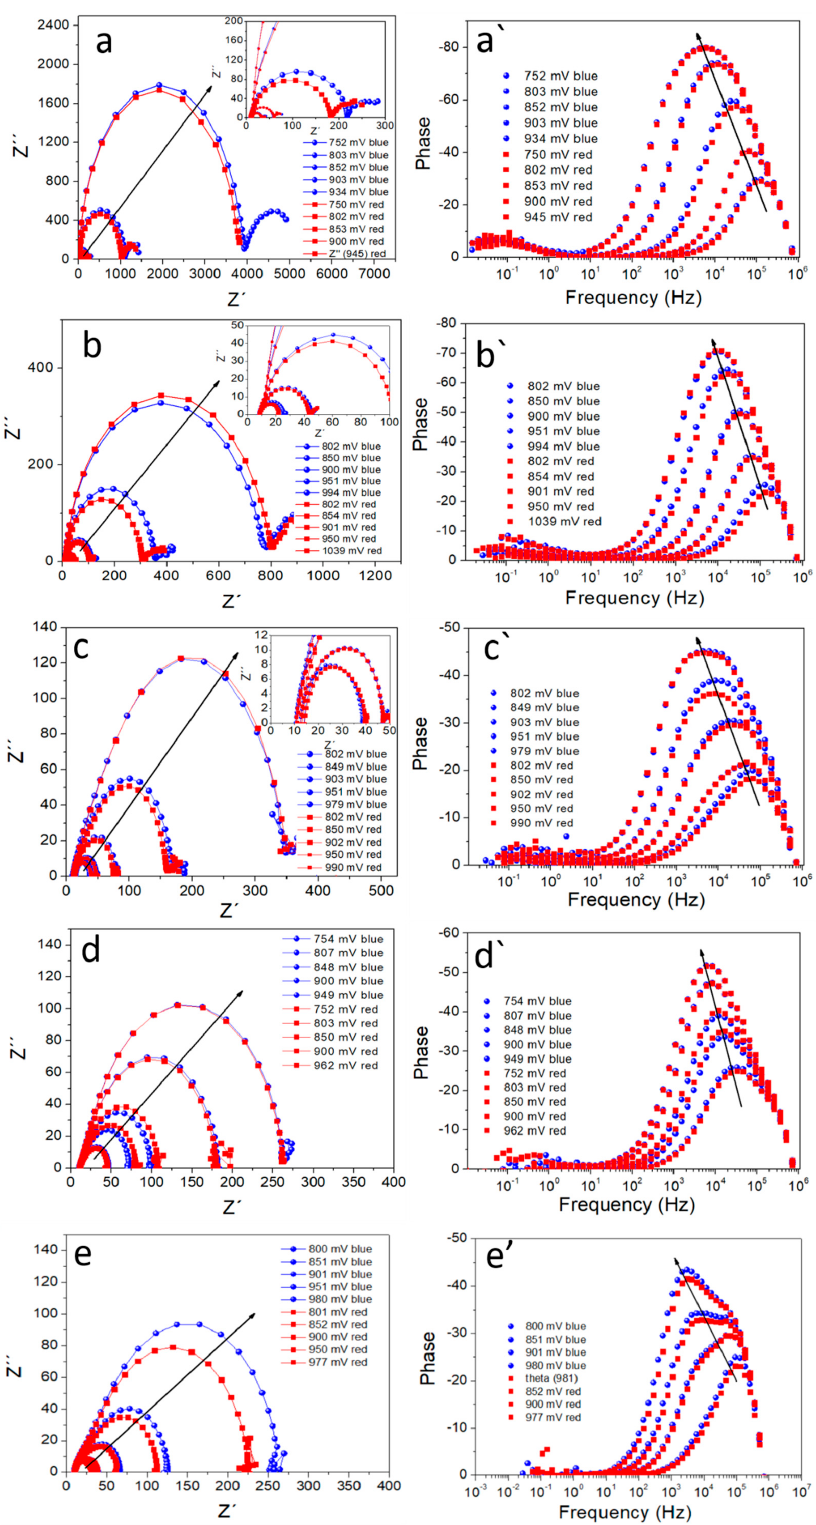
Figure 4. Nyquist ( a – e ) and Bode plots ( a‘ – e‘ ) at different applied voltages for CH 3 NH 3 PbI 3 perovskite solar cells using two excitation wavelengths, λ blue = 465 nm and λ red = 635 nm. Different configurations are labeled as follows: ( a , a‘ ) planar, ( b , b‘ ) mesoporous 1:7, ( c , c‘ ) mesoporous 1:3.5, ( d , d‘ ) nanocolumns 100 nm and ( e , e‘ ) nanocolumns 200 nm. Arrows indicate the evolution of the measurements when we measured from V OC to lower